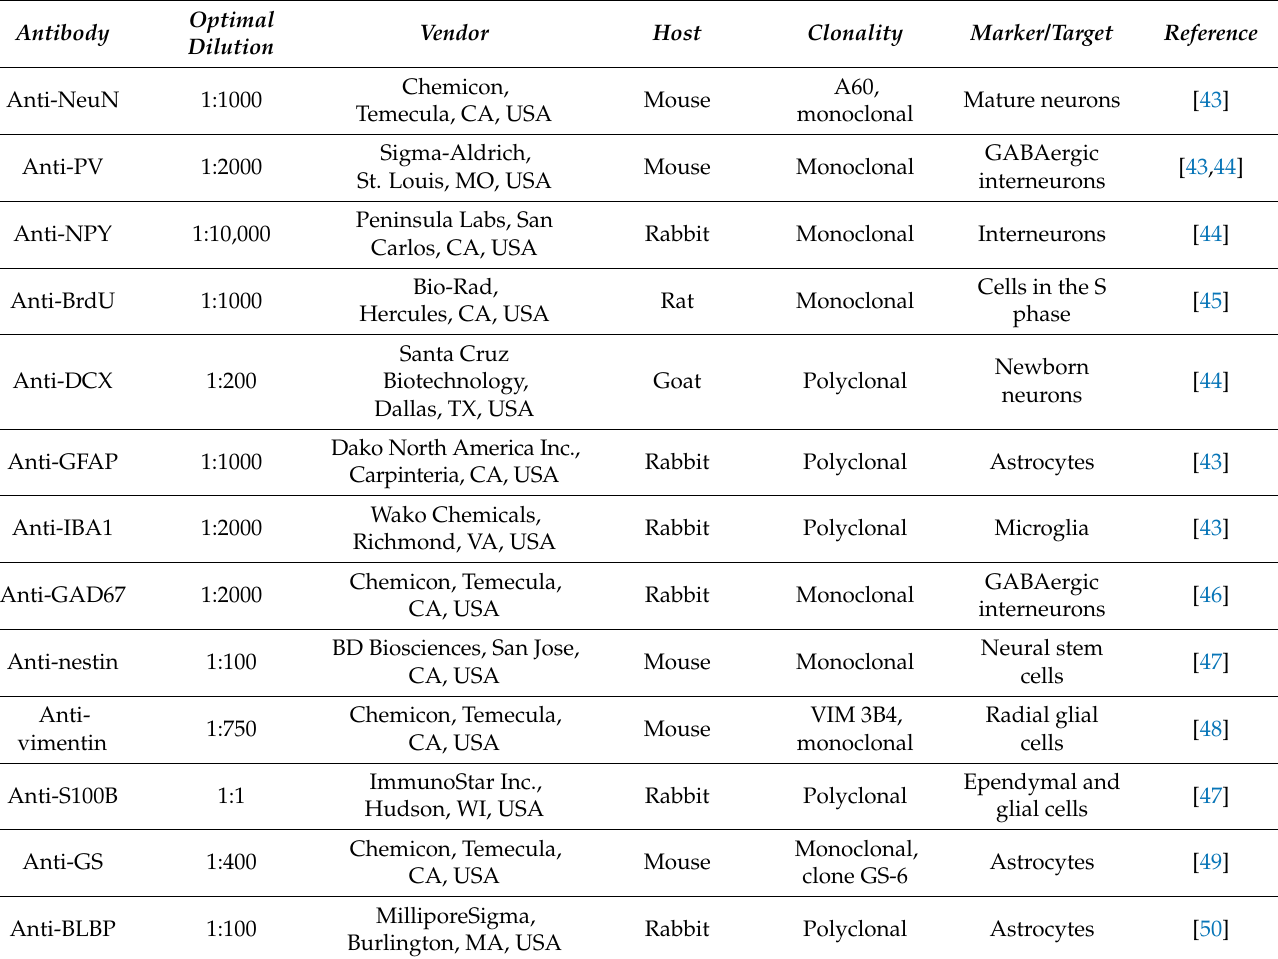
Table 4. Summary profile of primary antibodies used in lab biomarker